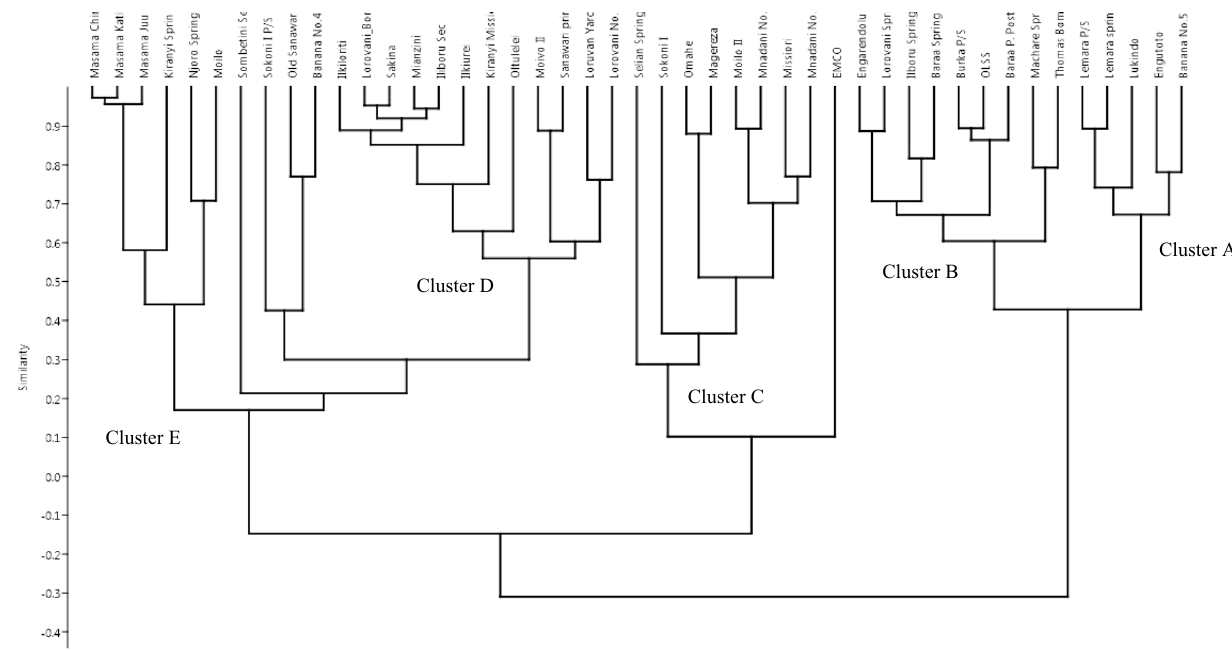
Fig. 8 Dendrogram for groundwater hydrogeochemical data from 45 sampling sites